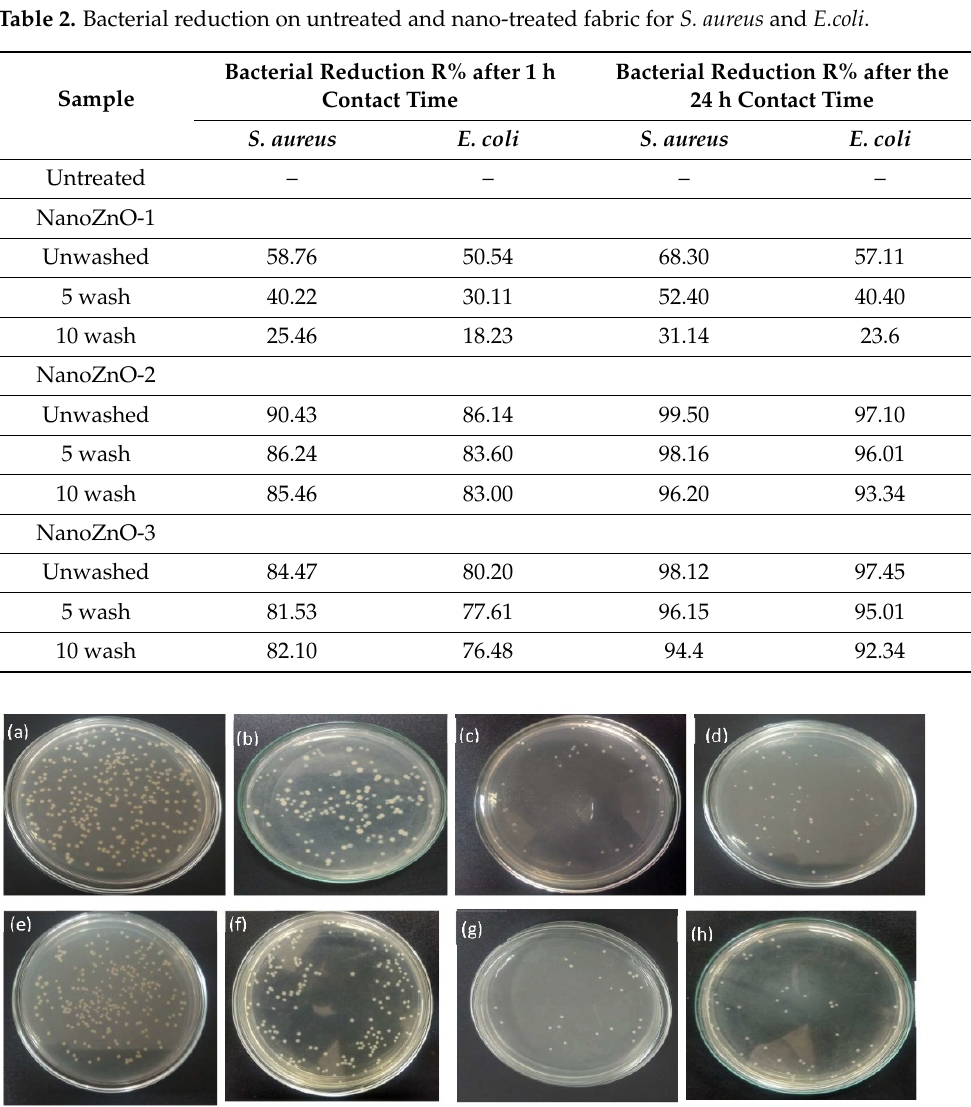
Figure 5. Bacterial reduction disk images of 1 h contact time for ( a ) untreated fabric, ( b ) NanoZnO-1, ( c ) NanoZnO-2, and ( d ) NanoZnO-3 for S. aureus ; ( e ) untreated fabric, ( f ) NanoZnO-1, ( g ) NanoZnO-2, and ( h ) NanoZnO-3 for E.coli. Table 2. Bacterial reduction on untreated and nano-treated fabric for S. aureus and E.coli.